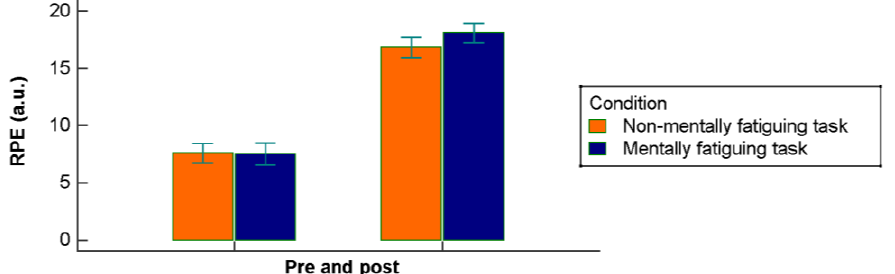
Figure 2. Subjective post-MSFT RPE pre and post broken down to the condition (experimental and control).